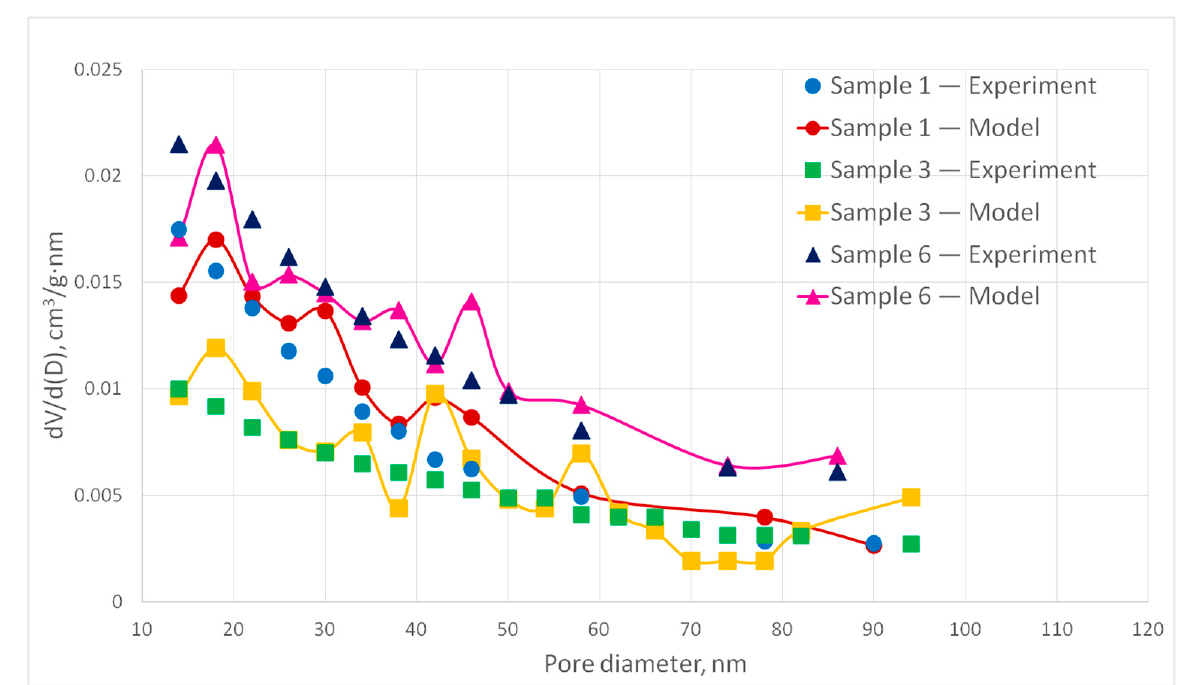
Figure 19. Experimental and corresponding digital structures PSD curves for samples 1, 3 and 6.